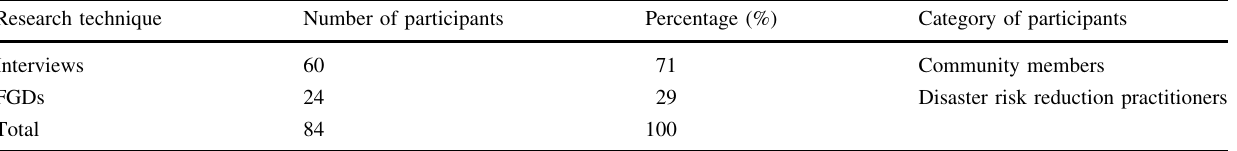
Table 1 In-depth interviews and focus group discussions (FGDs) adopted for data collection Research